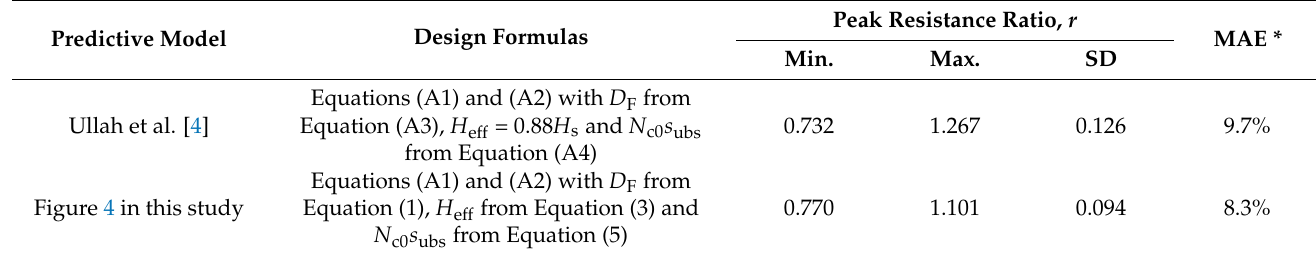
Table 2. Statistics for the performance of different predictive models.